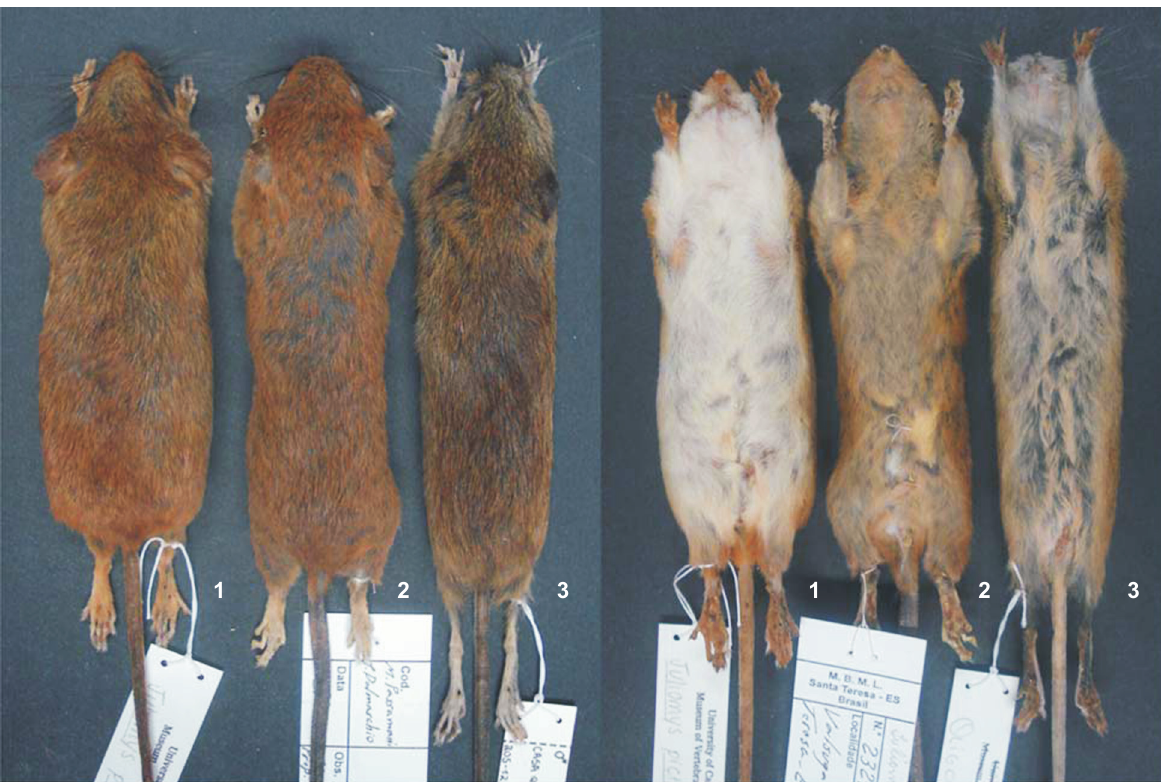
Figures 1-3. Dorsal and ventral views of the skins of: (1) J. pictipes (UFMG 3168); (2) Rhagomys rufescens (AB 401); (3) Oligoryzomys flavescens (UFES 1176).